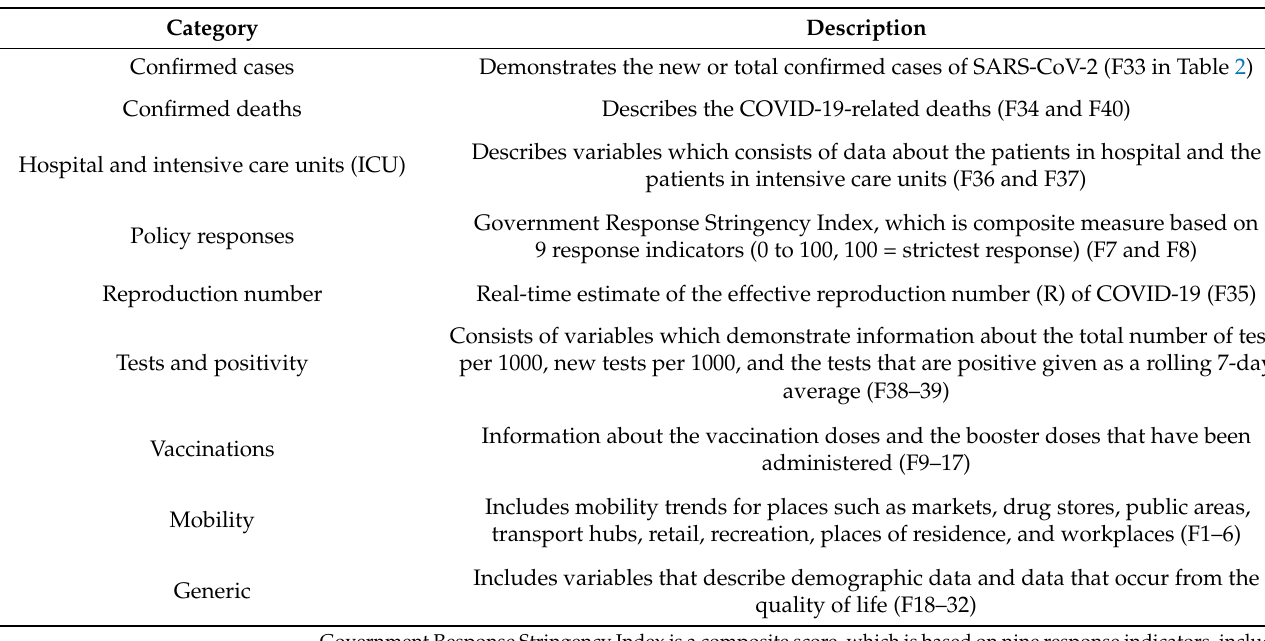
Table 1. Description of the feature categories in the employed